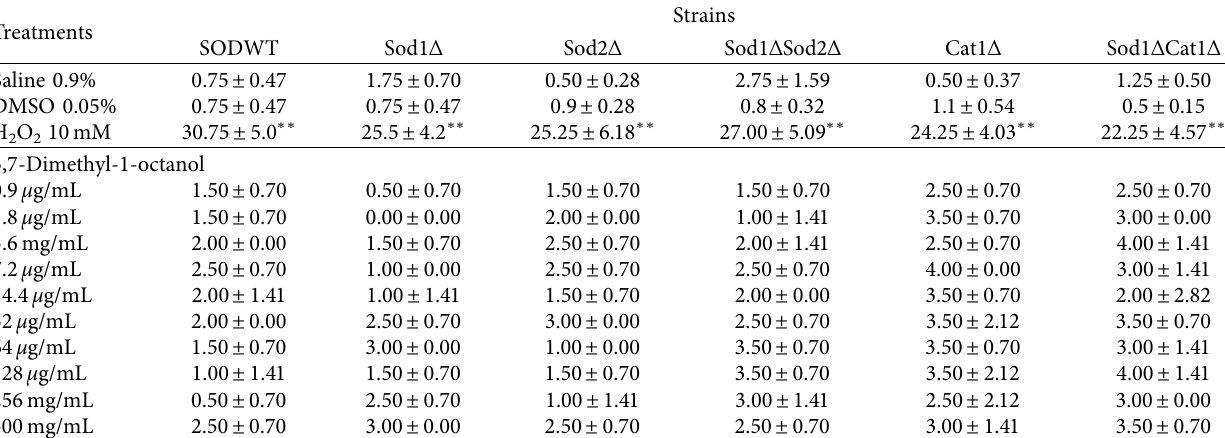
Table 5: Evaluation of oxidative damage by 3,7-dimethyl-1-octanol in profcient and defcient strains of Saccharomyces cerevisiae. Strains Treatments SODWT Sod1 ∆ Sod2 ∆ Sod1 ∆ Sod2 ∆ Cat1 ∆ Sod1 ∆ Cat1 ∆ Saline